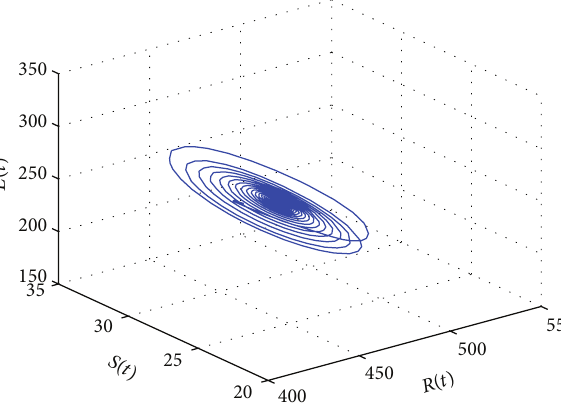
Figure 14: The phase plot of the states 𝑅 , 𝑆 , and 𝐸 for 𝜏 1 = 7.2000 < 7.8533 = 𝜏 ∗ 1 and 𝜏 ∗ 2 = 3 .